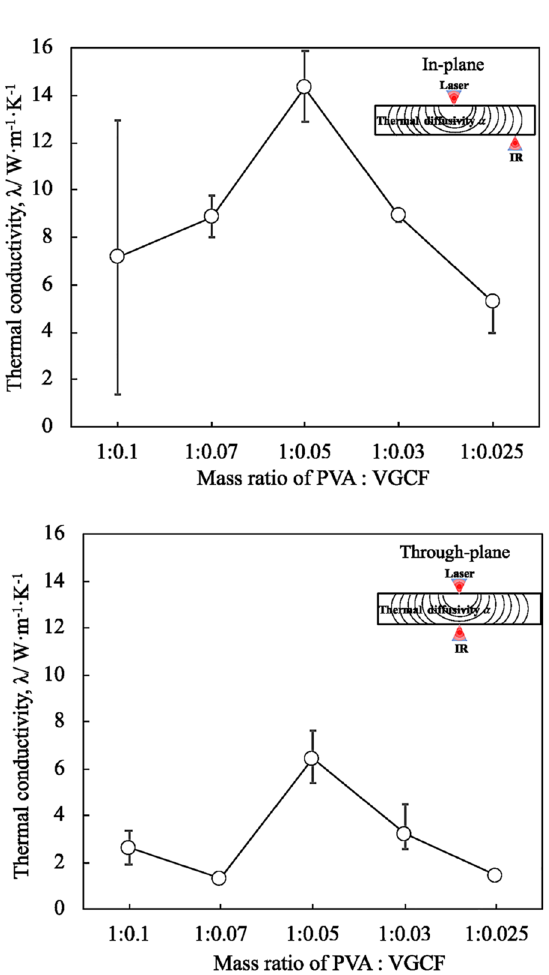
Figure 7. Effect of mass ratio of PVA and VGCF on in-plane and through-plane thermal